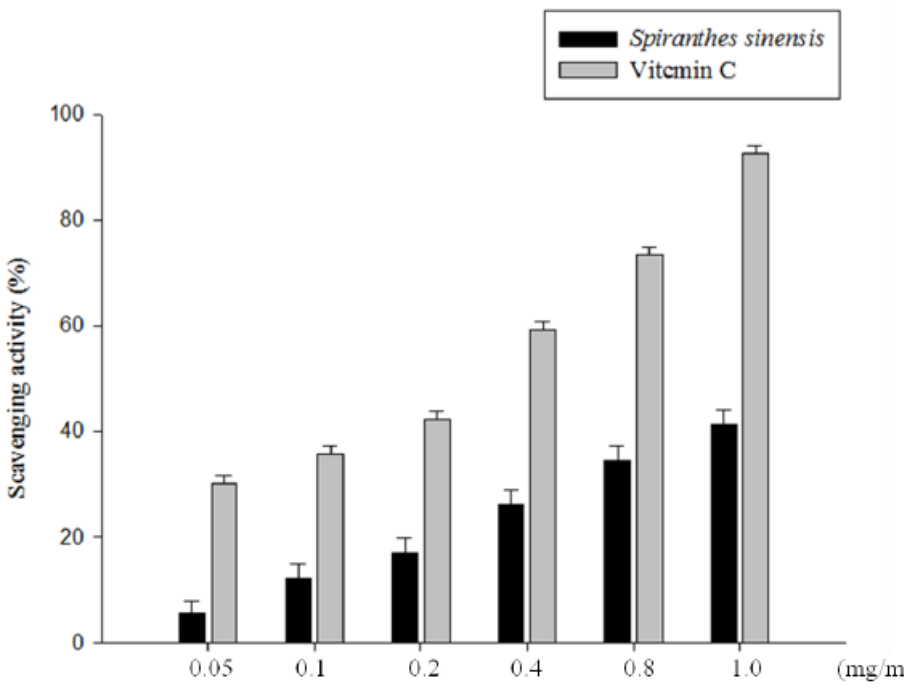
Figure 5. Superoxide radical scavenging capacity of S. sinensis E+U extract. The scavenging effects of the extract at different concentrations compared with vitamin C. Results are represented as percentages of control, and the data are mean ± SD for the three separate